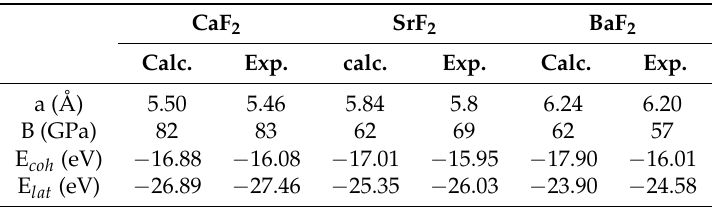
Table 1. Optimized lattice constant a 0 (Å), bulk modulus B (GPa), cohesive energy E coh (eV) and lattice energy E lat (eV) for CaF 2 , SrF 2 and BaF 2 calculated at the PBE level. The energy values are counterpoise corrected. Experimental values are given for